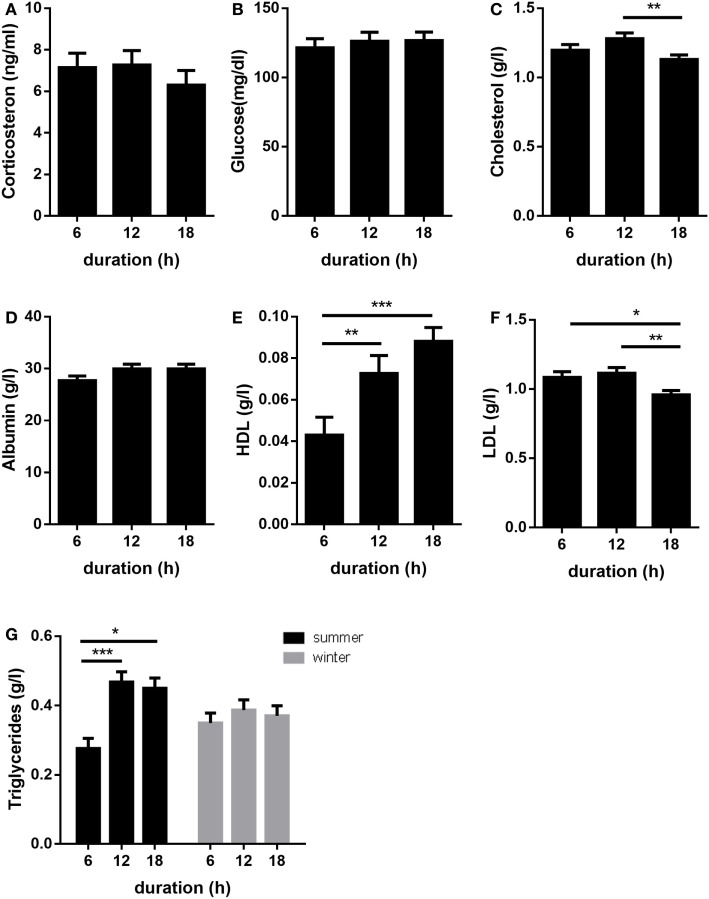
Effects of transport duration on plasma levels of corticosterone (A), glucose (B), albumin (C), cholesterol (D), HDL (E), LDL (F), and triglycerides (G) (n = 28–30 per duration for all parameters). Data except triglycerides include the summarized data of the trials in January/February and July due to the absence of the significant interaction duration × environment. A significant interaction of duration × environment (p < 0.05) was calculated for TG. All data are presented as LS-Means + SE *p < 0.05, **p < 0.01, ***p < 0.001; LDL = low-density lipoprotein, HDL = high-density lipoprotein.